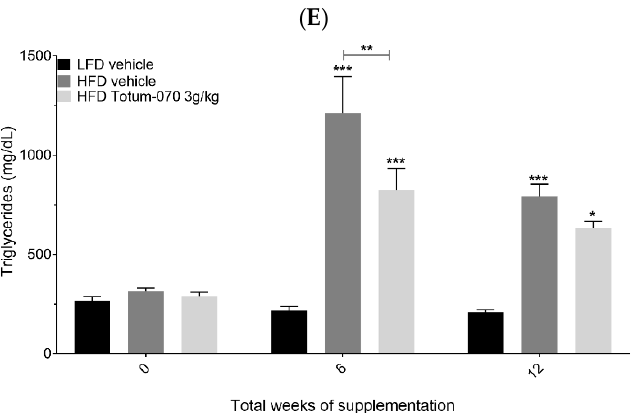
Figure 1. Effect of Totum-070 supplementation on circulating lipid parameters in high fat-fed ham- sters. ( A ) Experimental design. ( B ) Total cholesterol. ( C ) non-HDL cholesterol. ( D ) HDL cholesterol. ( E ) Triglycerides. Values are presented as the means ± SEM unless specified otherwise. The differ- ences were considered statistically significant at p < 0.05 with * for p < 0.05; ** for p < 0.01; *** for p < 0.001. Total cholesterol: global p -values (time < 0.001; column factor < 0.001; time × column factor < 0.001); F values (time F = 263; column factor F = 143; time x column factor F = 57.9); HDL cholesterol: global p -values (time < 0.001; column factor < 0.001; time × column factor = 0.01); F values (time F = 14.9; column factor F = 13.3; time × column factor F = 3.43); non-HDL cholesterol: global p -values (time < 0.001; column factor < 0.001; time × column factor = 0.01); F values (time F = 212; column factor F = 89.6; time × column factor F = 48.2); Total triglycerides: global p -values (time < 0.001; col- umn factor < 0.001; time × column factor < 0.001); F values (time F = 17.2; column factor F = 18.4; time × column factor F = 5.40).